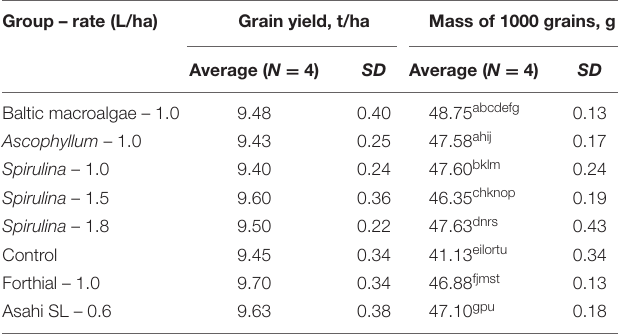
TABLE 5 | Winter wheat yield and yield